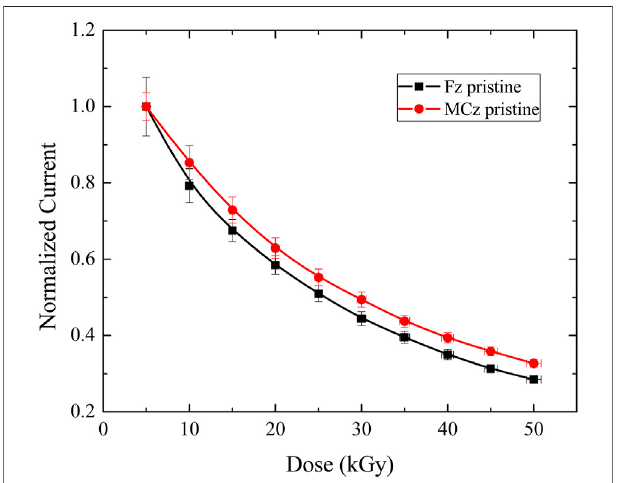
FIGURE 3 | Decrease in the induced currents delivered by Fz and MCz diodes over 50 kGy normalized to the maximum values at the beginning of irradiation.